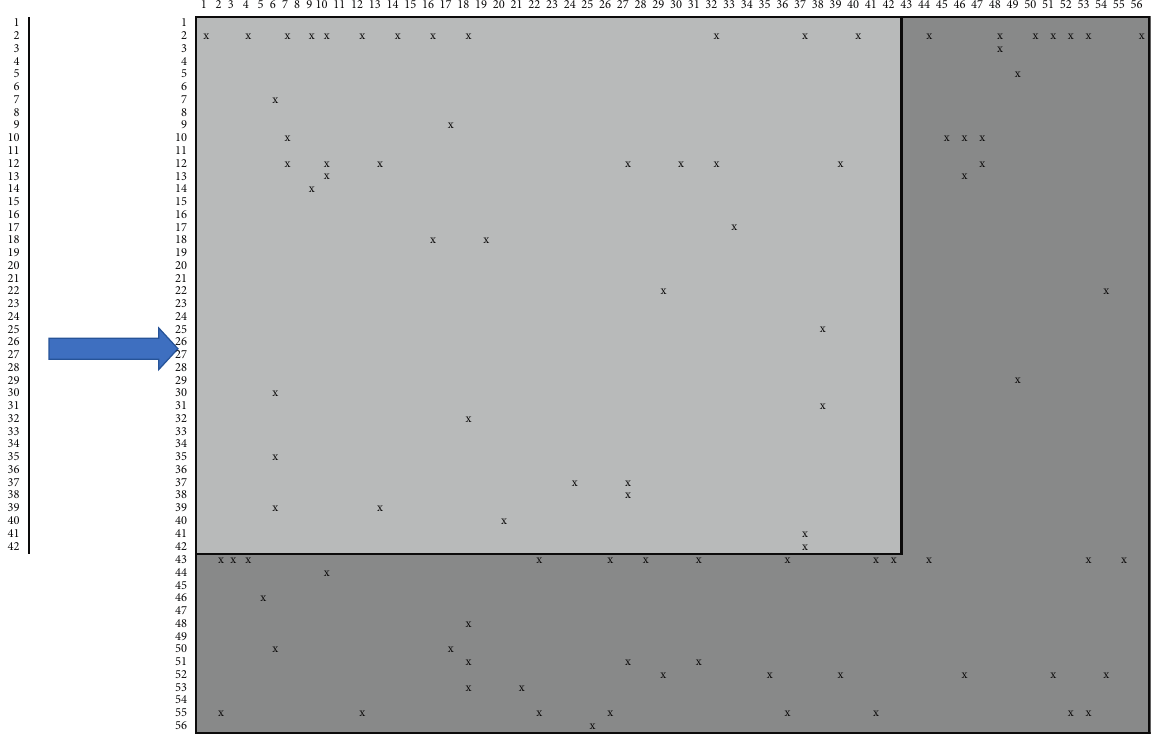
Figure 2: From an initial 42-risk list to a 56 ∗ 56 risk interdependence matrix (tramway project case). Table 3: The 56-risk list with associated class, owner, and